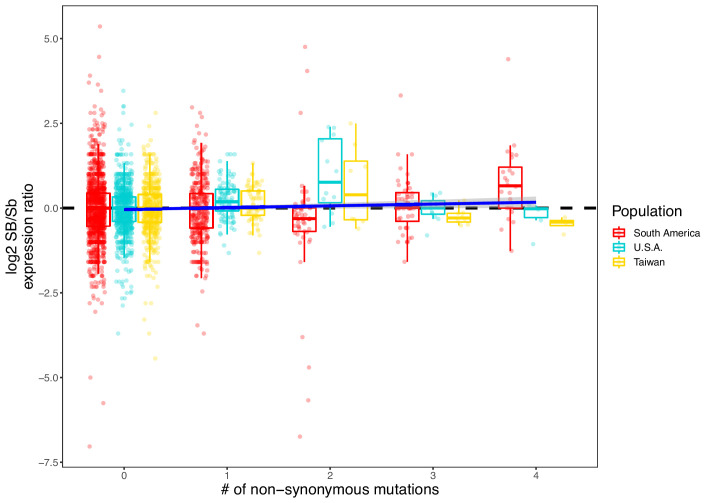
Allelic bias measured as the log2 ratio of expression between the SB and Sb alleles compared to the number of nonsynonymous mutations per gene.Positive values indicate higher expression in SB; negative values indicate higher expression in Sb. Allelic expression bias was measured in all populations analyzed in this study: South America, U.S.A. and Taiwan. Each dot represents a gene from a sample in each population. Because genes with low expression result in noisy log2 ratios of expression, we excluded genes with a median expression of 5 reads or fewer). A linear regression (dark blue line, ‘log2 ratio’ ~ ‘Population’ + ‘Sample’ + ‘Number of nonsynonymous mutations’) shows that, overall, SB bias increases with the number of nonsynonymous mutations (coefficient = 0.052, p=0.01).Figure 4—figure supplement 2—source data 1.Effect of non-synonymous mutations in the allelic bias between SB and Sb.The columns in the dataset stand for: gene, gene ID in the RefSeq database, reads_b, raw read counts per gene per sample for the Sb allele; sample, replicate ID, population, population to which the replicate belongs; reads_B raw read counts per gene per sample for the SB allele; total_reads, combined SB and Sb expression per gene; median_expression, median read count per gene across all samples; lfc, log2 fold changes between SB and Sb expression levels; missense_muts, number of missense mutations, stop_gain_id, number of stop codon gain mutations; stop_loss_id, number of stop codon loss mutations; all_nonsyn_muts, total number of non-synonymous mutations.